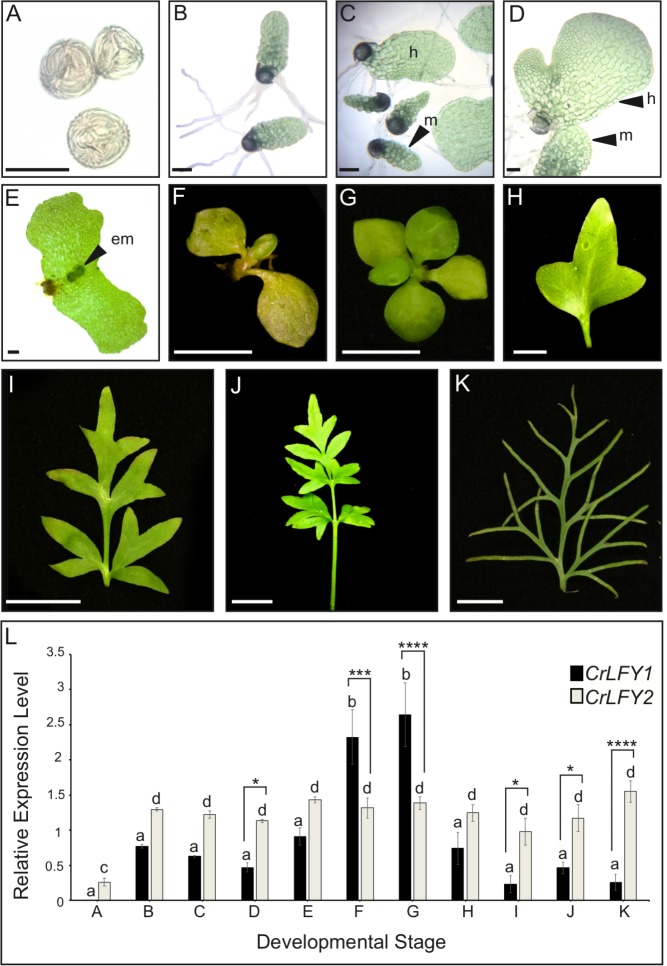
CrLFY1 and CrLFY2 are differentially expressed during the Ceratopteris lifecycle.(A-K) Representative images of the developmental stages sampled for expression analysis in (L). Imbibed spores (A); populations of developing gametophytes harvested at 5 (B, C) and 8 (D) days after spore-sowing (DPS), comprising only males (B) or a mixture of hermaphrodites (h) and males (m) (C, D); fertilized gametophyte subtending a developing sporophyte embryo (em) (E); whole sporophyte shoots comprising the shoot apex with 3 (F) or five expanded entire fronds attached (G); individual vegetative fronds demonstrating a heteroblastic progression in which frond complexity increases through successive iterations of lateral outgrowths (pinnae) (H–J); complex fertile frond with sporangia on the underside of individual pinnae (K). Scale bars = 100 um (A–E), 5 mm (F–H), 20 mm (I–K). (L) Relative expression levels of CrLFY1 and CrLFY2 (normalized against the housekeeping genes CrACTIN1 and CrTBP) at different stages of development. n = 3; Error bars = standard error of the mean (SEM). Pairwise statistical comparisons (ANOVA followed by Tukey’s multiple comparisons test– Supplementary file 4) found no significant difference in CrLFY2 transcript levels between any gametophyte or sporophyte tissues sampled after spore germination (p>0.05) and no significant difference between CrLFY1 and CrLFY2 transcript levels during early gametophyte development (p>0.05) (B, C). Differences between CrLFY1 and CrLFY2 transcript levels were significant in gametophytes at 8 DPS (p<0.05) (D). CrLFY1 transcript levels were significantly higher in whole young sporophytes (F) and vegetative shoots (G) compared to isolated fronds (H–K) (p<0.05). CrLFY1 transcript levels in whole sporophytes and shoots were greater than CrLFY2, whereas in isolated fronds CrLFY1 transcript levels were consistently lower than CrLFY2 (p<0.05). Asterisks denote significant difference (*, p<0.05; **, p<0.01, ***, p<0.001; ****, p<0.0001) between CrLFY1 and CrLFY2 transcript levels (Sidak’s multiple comparisons test) within a developmental stage. Letters denote significant difference (p<0.05) between developmental stages for CrLFY1 or CrLFY2 (Tukey’s test). Groups marked with the same letter are not significantly different from each other (p>0.05). Statistical comparisons between developmental stages were considered separately for CrLFY1 and CrLFY2. The use of different letters between CrLFY1 and CrLFY2 does not indicate a significant difference.10.7554/eLife.39625.008Figure 3—source data 1.CrLFY qRT-PCR ontogenic expression data